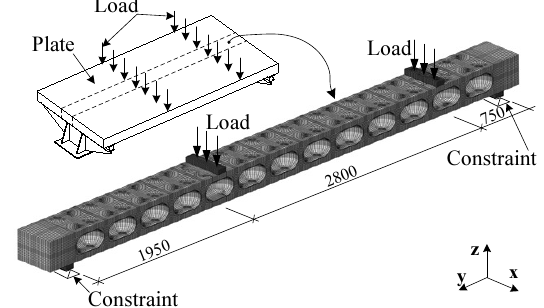
Fig. 8. Scheme for a numerical model